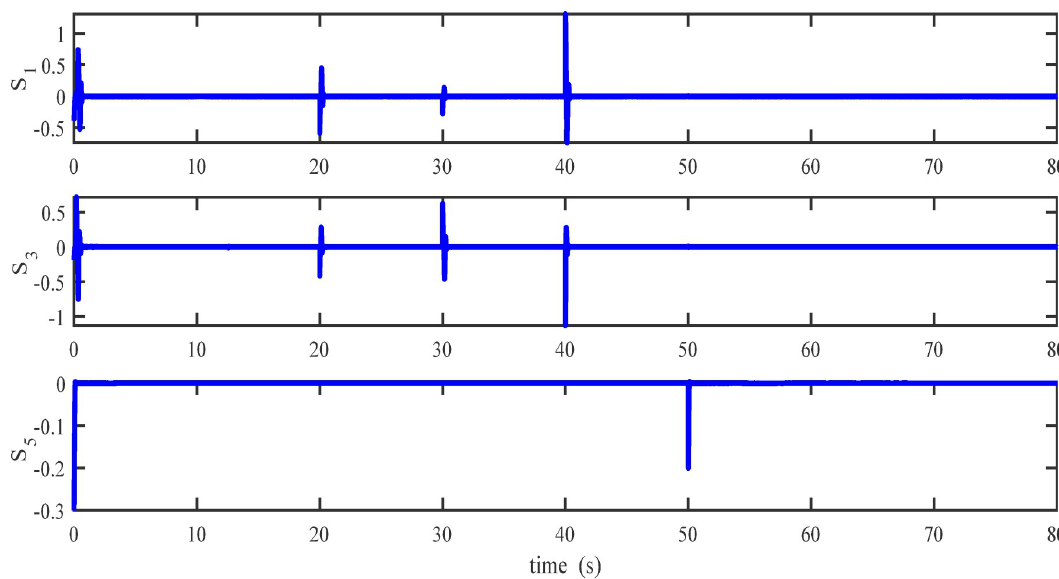
Fig 8. Results of the attitude sliding variables under the proposed controller.